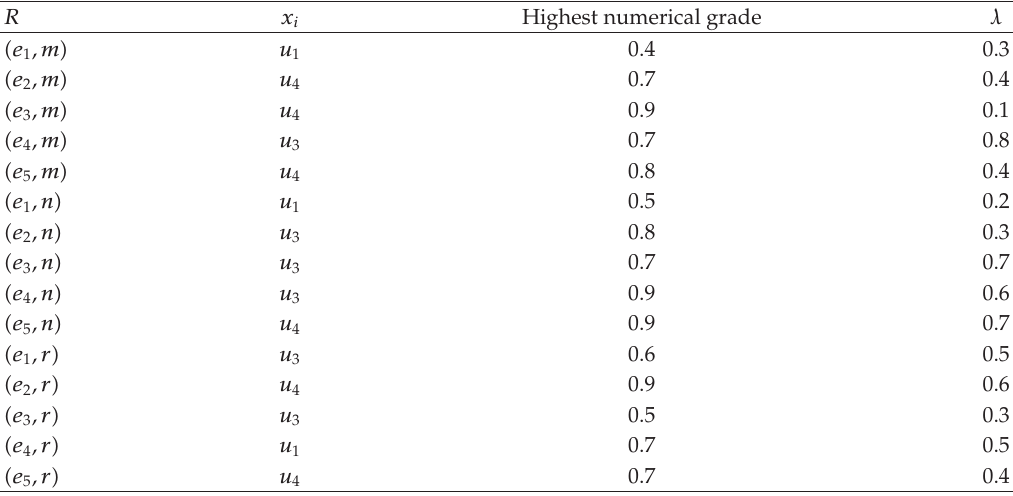
Table 3: Grade table of agree-generalized fuzzy soft expert set.